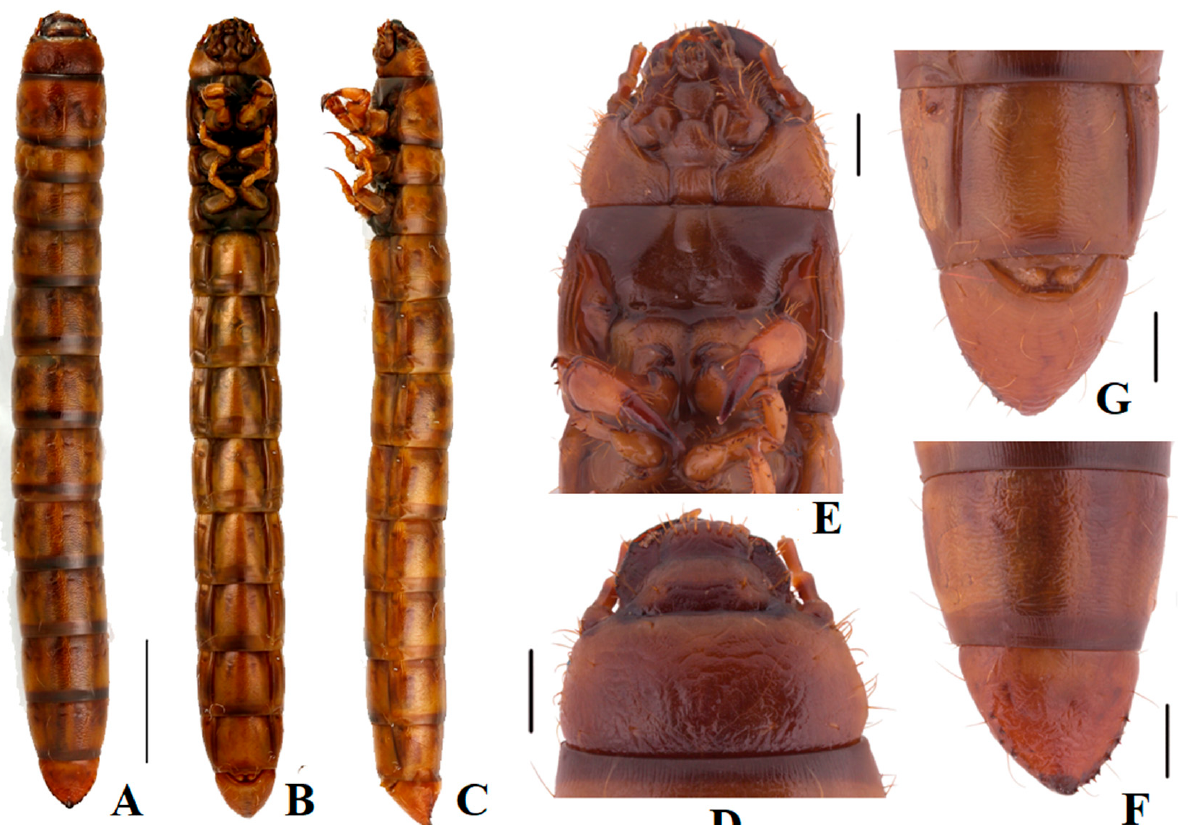
Figure 2. Larva of Nalepa cylindracea . ( A – C ) Habitus: ( A ) dorsal view; ( B ) ventral view; ( C ) lateral view. ( D ) Head, dorsal view; ( E ) Head and prothoracic leg, ventral view; ( F ) Pygopods, dorsal view; ( G ) Pygopods, ventral view. Scale bars: 5 mm ( A – C ), 1 mm ( D – G ).